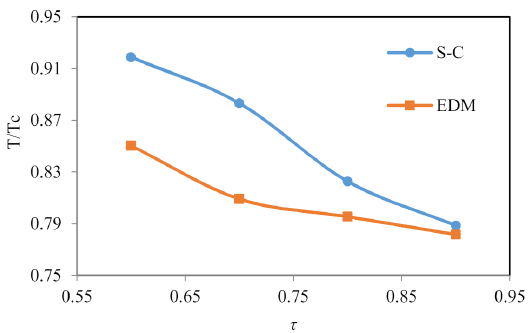
Figure 1. Comparison between the achievable lowest temperature with different forcing schemes at various relaxation times. Velocity-shift force scheme is presented in the graph as S-C.